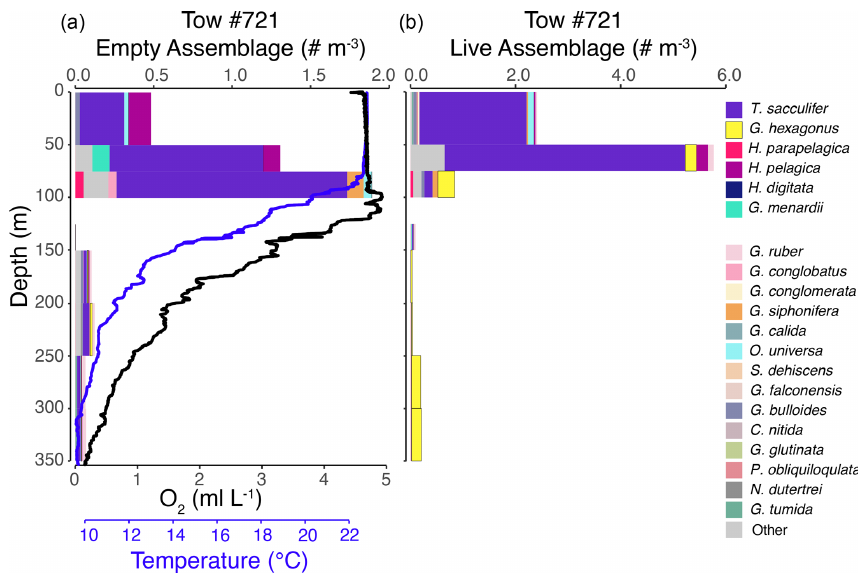
Figure 5. Vertical profiles of the empty assemblage, dissolved oxygen, and temperature (a) and live foraminiferal assemblage (b) from tow no. 721 (0–350m). Each color represents a different species (see legend). Abundance axes vary between panels.